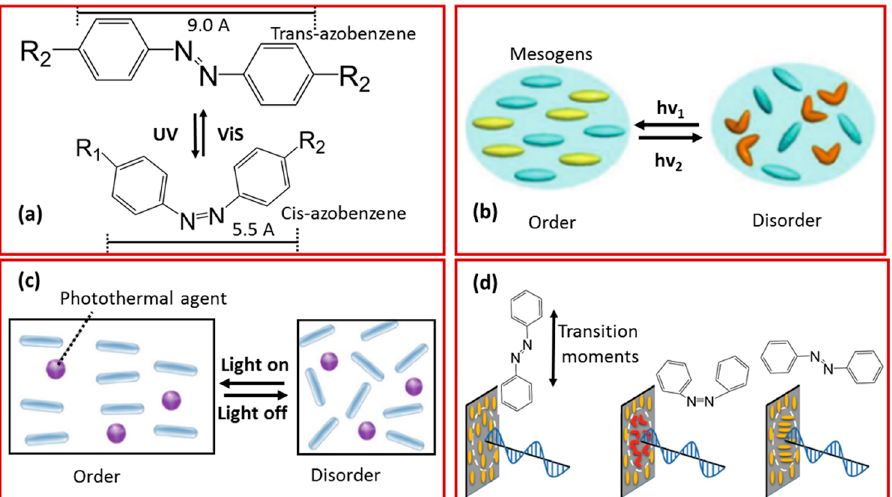
Figure 6. ( a ) Reversible trans–cis photo-isomerization of azobenzene and schematic illustration of ( b ) photo-induced and ( c ) photothermal-induced order–disorder phase transition in LCPs (Reprinted (adapted) with permission [101] . Copyright (2019) John Wiley and Sons). ( d ) Photo-reorientation of azobenzene containing LCPs with linearly unpolarised light (Reprinted (adapted) with permission [96]. Copyright (2019) John Wiley and Sons).